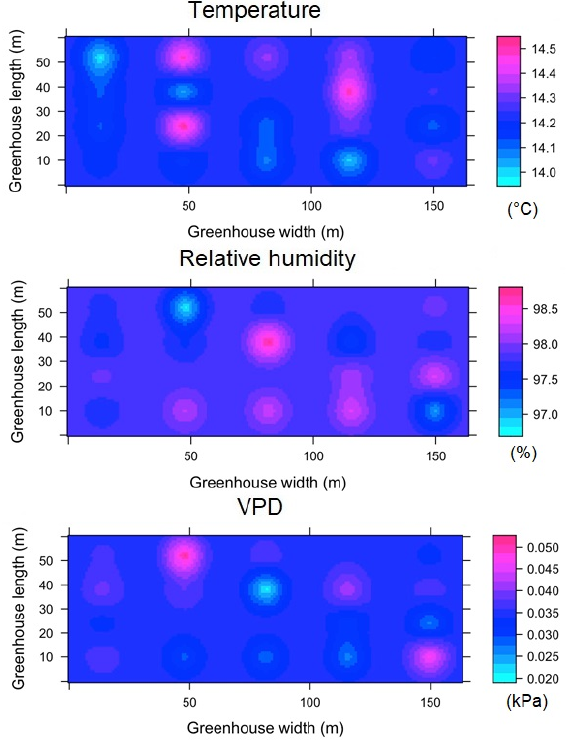
Figure A10. Spatial distribution predicted by kriging, for temperature, relative humidity and VPD in HGT1 and for ESRL 2.